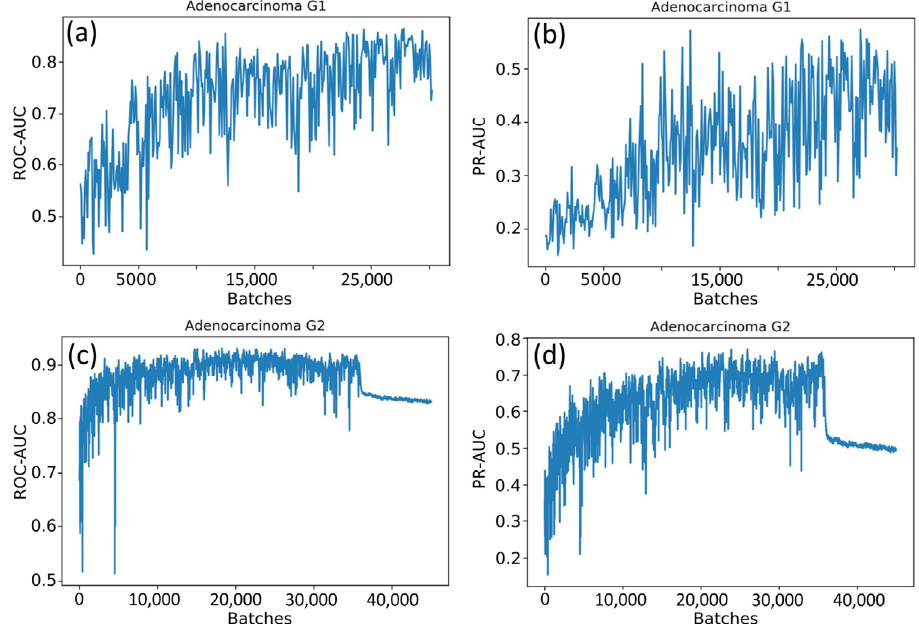
Figure 5. Changes in metrics during the training process: ( a ) the ROC-AUC metric for the adenocar- cinoma G1 class; ( b ) the PR-AUC metric for the adenocarcinoma G1 class; ( c ) the ROC-AUC metric for the adenocarcinoma G2 class; and ( d ) the PR-AUC metric for the adenocarcinoma G2 class. Figures 6 and 7 show the ROC and PR curves for the best trained models.